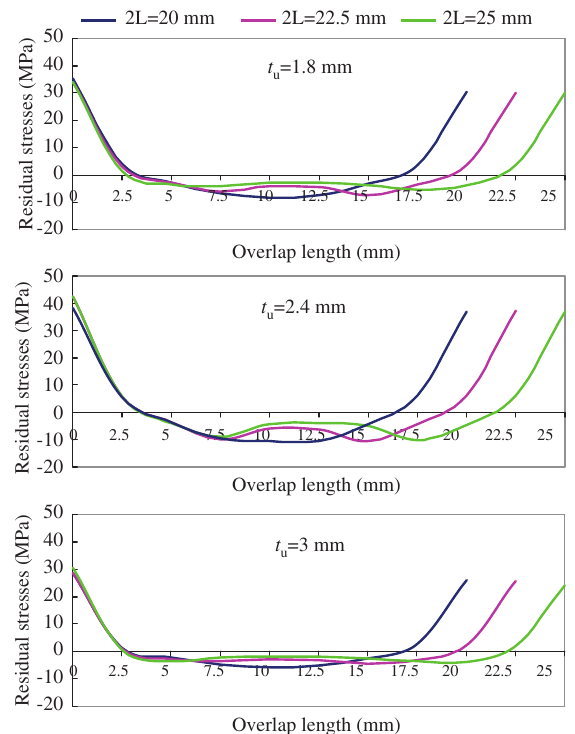
Figure 13 Effect of adhesive length on the residual shear stress for adhesive thickness of t thickness.